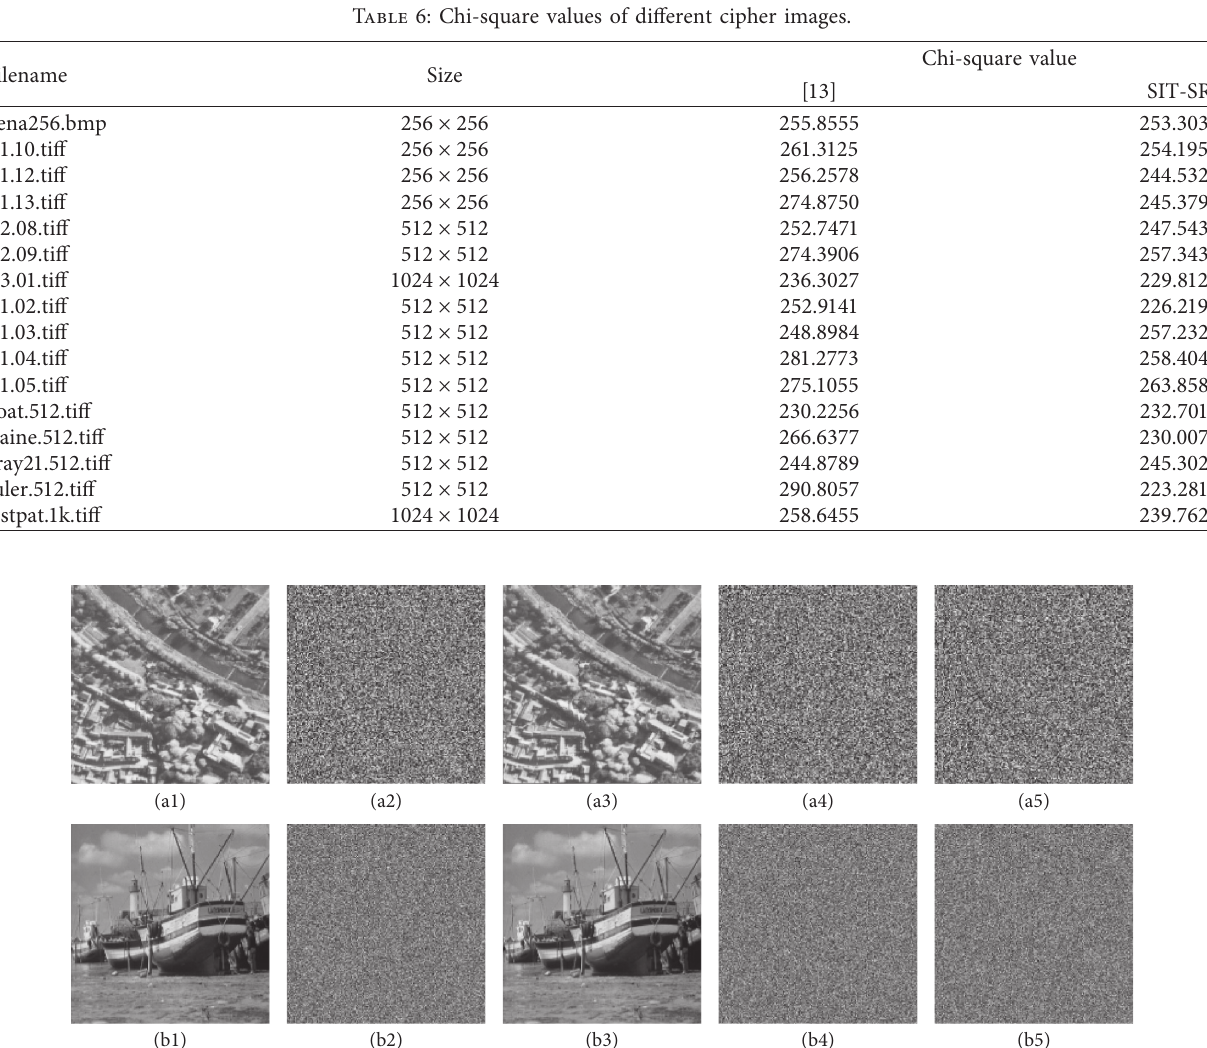
Figure 11: Plain image sensitivity test results for SIT-SR: (a1) 5.1.10.tiff; (a2) cipher image of (a1); (a3) the least significant bit of the pixel